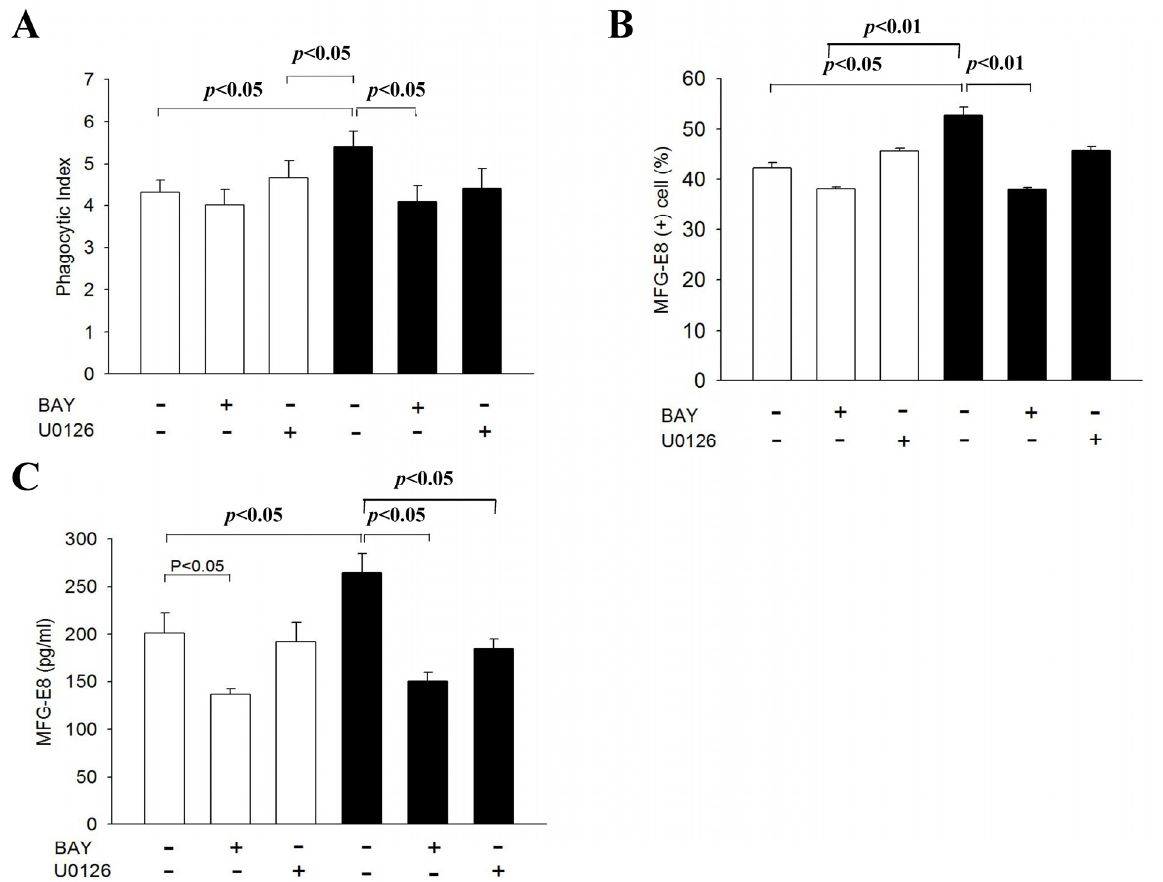
Figure 6. CX3CL1 promotes phagocytic activity of NR8383 cells via the NF- κ b signal transducing pathway. ( A – C ) NR8383 cells were first treated with either Bay (BAY11–7082; a NF- κ b inhibitor) or U0126 (a MARK inhibitor), and this was followed by either exogenous CX3CL1 treatment (black bar) or no treatment (blank bar), before determining ( A ) the phagocytic activity of NR8383 cells when engulfing apoptotic cells; ( B ) the expression of MFG-E8 by flow cytometric analysis; and ( C ) the level of MFG-E8 in the CM of NR8383 cell cultures by ELISA. The results are the means ± SD from four ( A , C ) and five ( B ) independent experiments.